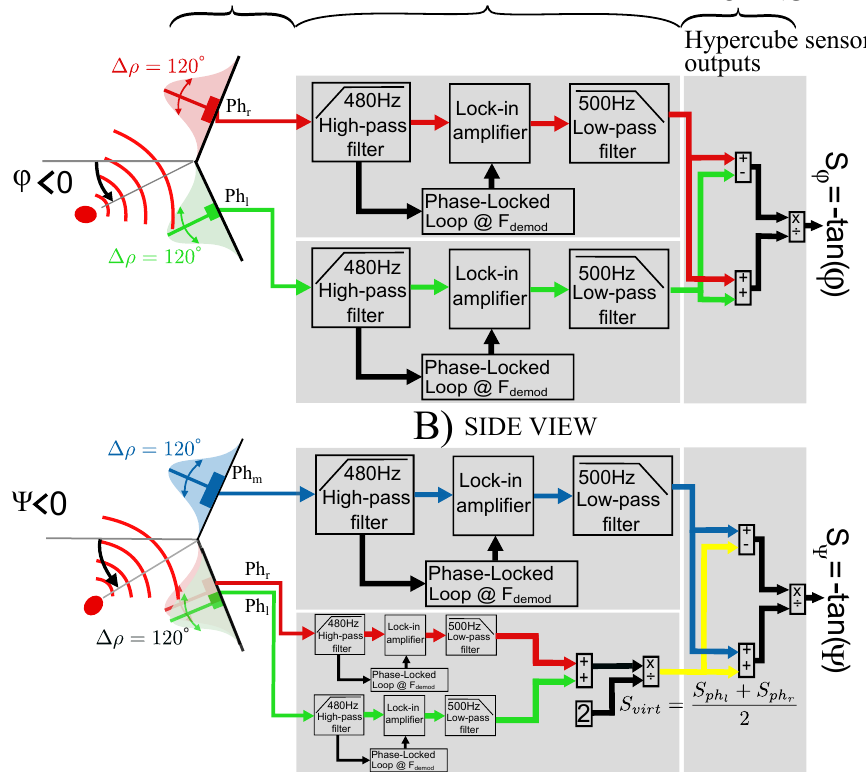
Figure 4. Sketch diagram of the signal processing algorithm. ( A ). Top view: The sensor measures the azimuth ϕ . The left part shows the IR LED modulated at a frequency noted F demod (11 kHz or 17 kHz). In this view, HyperCube is composed of two photosensors Ph l and Ph r with their respective cosine-like angular sensitivities (see Figure 3B). ( B ). Side View: The same signal processing is applied on the signal provided by the photosensor Ph m of HyperCube and a virtual photosensor where S virt =